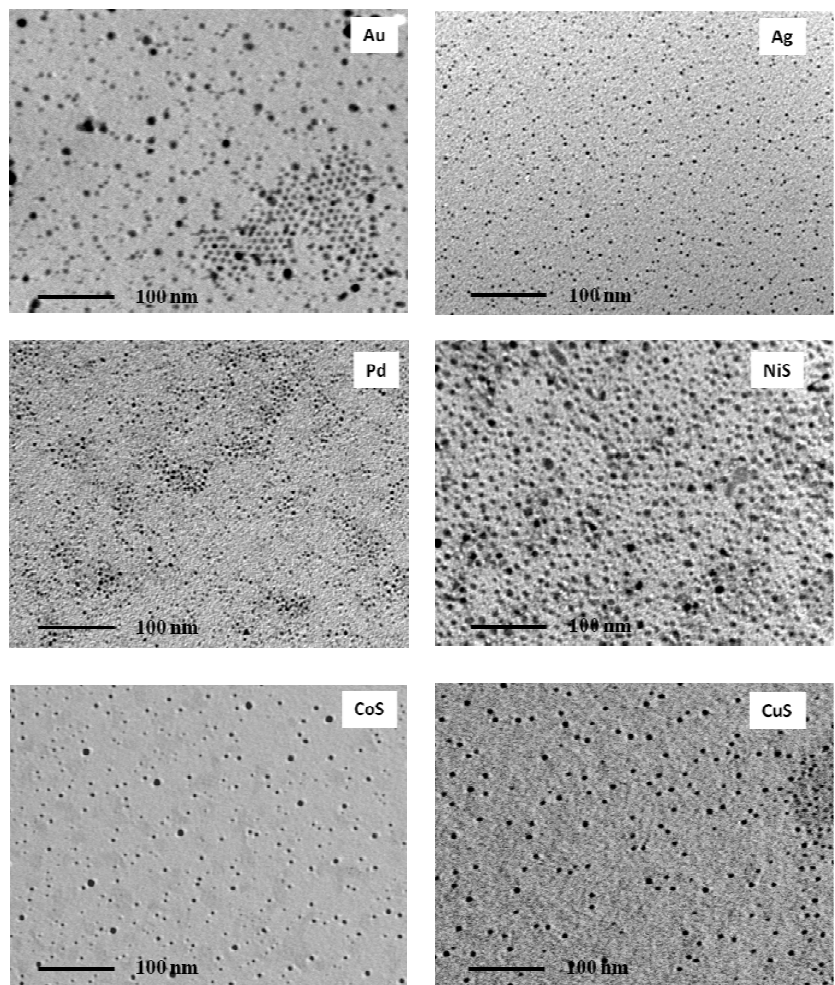
Figure 6. TEM-micrographs of different metal and metal sulfide clusters embedded into an amorphous polystyrene matrix, obtained by thermal decomposition of the corresponding metal-dodecylthiolate compounds